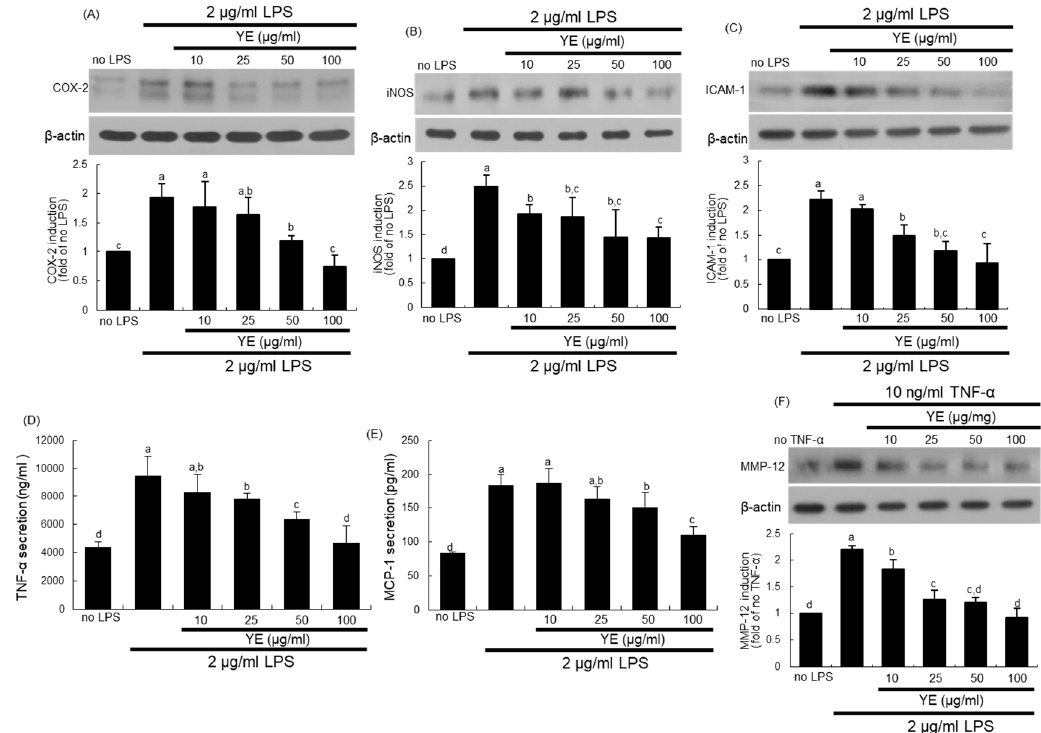
Figure 7. Blockade of alveolar inflammation by dried yeast extracts (YE) in lipopolysaccharide (LPS)-exposed A549 cells. Alveolar epithelial cells were incubated in media containing 2 µ g / mL LPS or 10 ng / ml TNF- α in the absence and presence of 10–100 µ g / mL YE for up to 24 h. Cell lysates were prepared for Western blot analysis with a primary antibody against COX-2, iNOS, ICAM-1, or MMP-12 ( A – C , F ). β -Actin protein was used as an internal control. The bar graphs (mean ± SEM, n = 3) represent quantitative results of the upper bands obtained from a densitometer. Alveolar secretion of TNF- α and MCP-1 was measured by using ELISA kits ( D , E ). Values in respective bar graphs not sharing a same small letter indicate a significant di ff erence at p < 0.05.